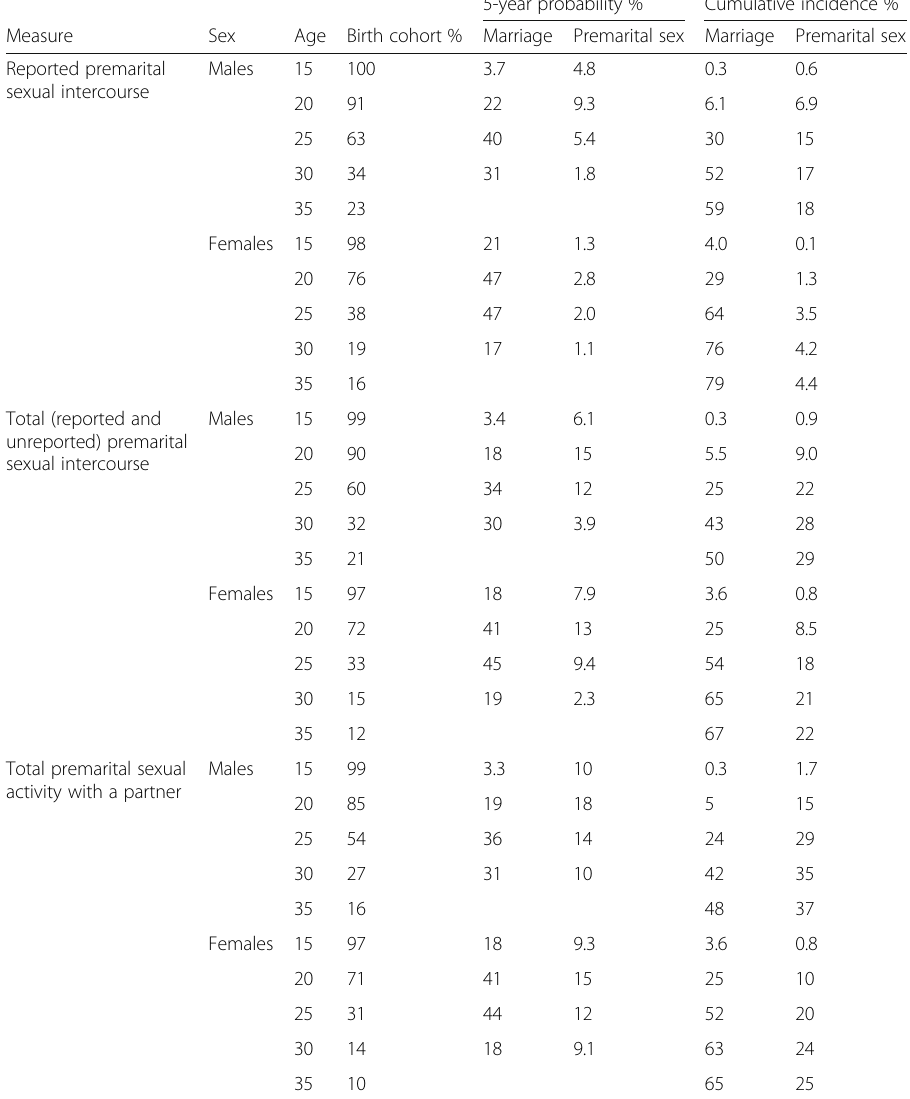
5-year probability % Cumulative incidence %